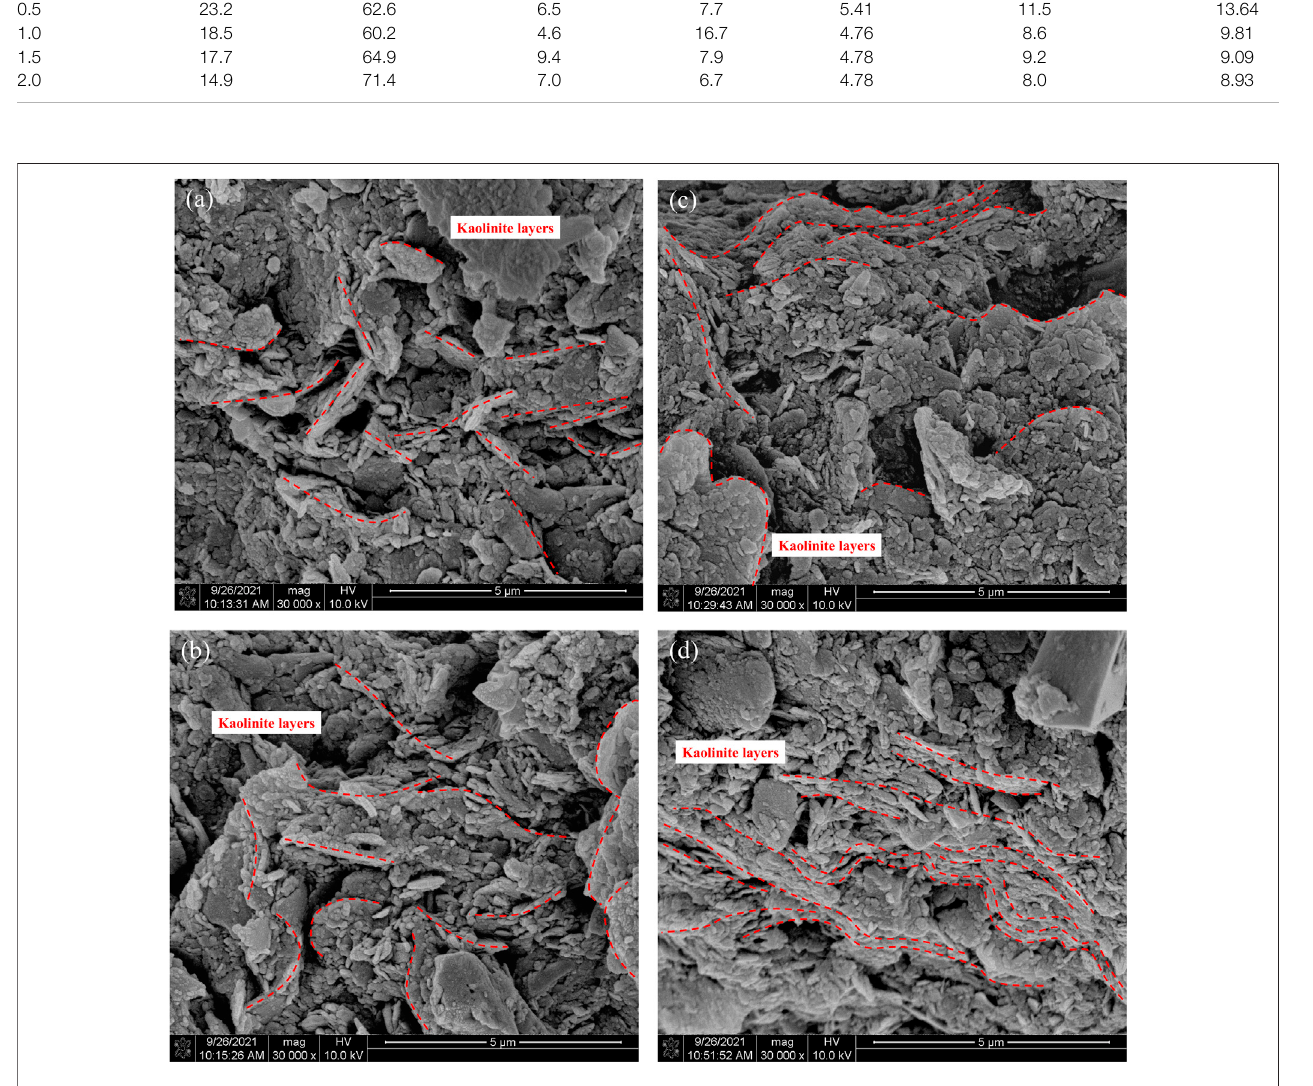
Frontiers in Earth Science |